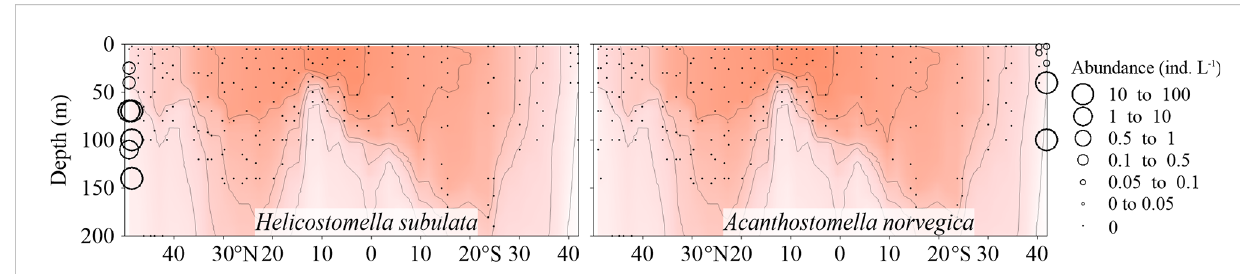
FIGURE 3 Vertical abundance (ind. L -1 ) distribution of Helicostomella subulata and Acanthostomella norvegica along the AMT transect. The red color and isothermal lines are temperature (°C) as in Figure 2. Black dots denote the locations of sample